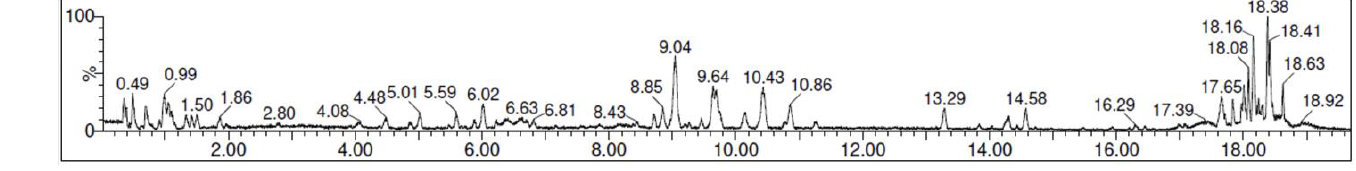
Figure 2. UPLC-QTOF-MS/MS chromatogram of the avocado honey extract. Table 3. Phenolic compounds identification in the extract of avocado honey.